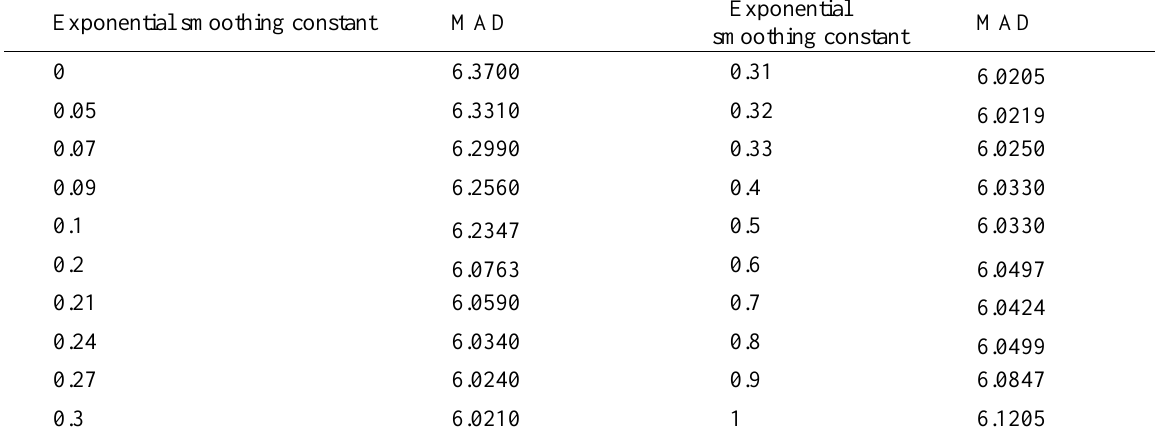
Table 2. MSE for different values of α.